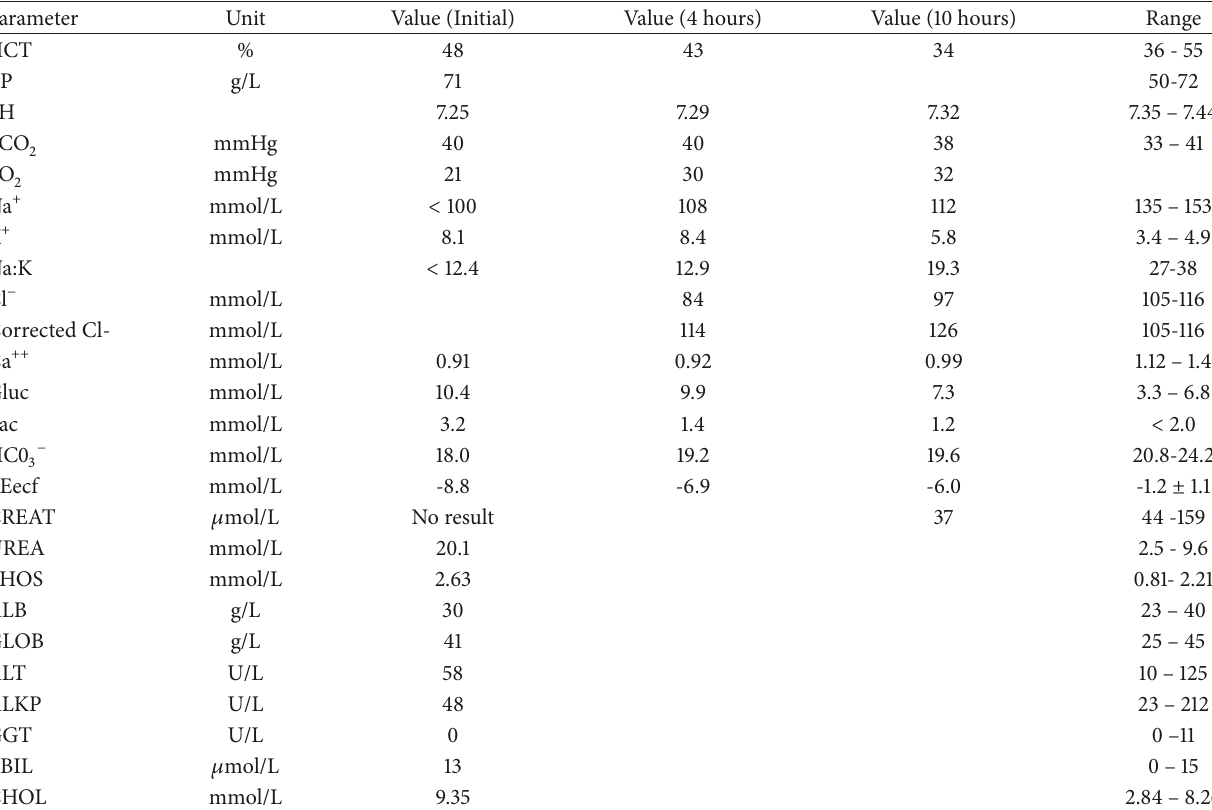
Table 1: Initial blood results after admission and treatment